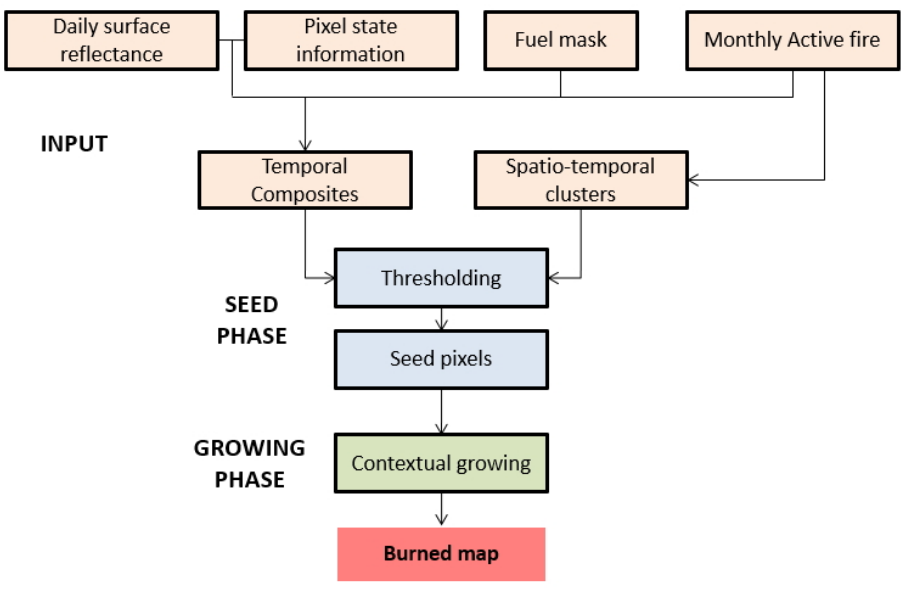
Figure 1. Simplified version of the main scheme of the global BA algorithm. Adapted from [30].